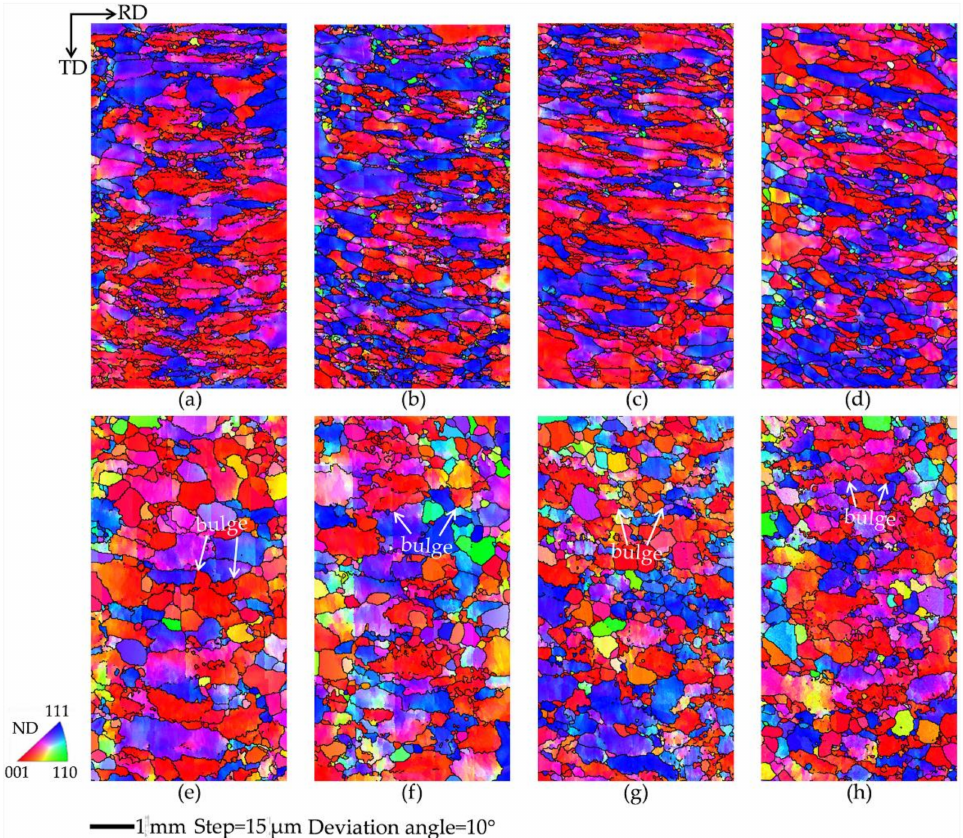
Figure 3. Microstructure under two deformation conditions, 900 ◦ C with 5 s − 1 ( a – d ) and 1150 ◦ C with 1 s − 1 ( e – h ), for four initial textures: ( a , e ) initial texture I, ( b , f ) initial texture II, ( c , g ) initial texture III, and ( d , h ) initial texture